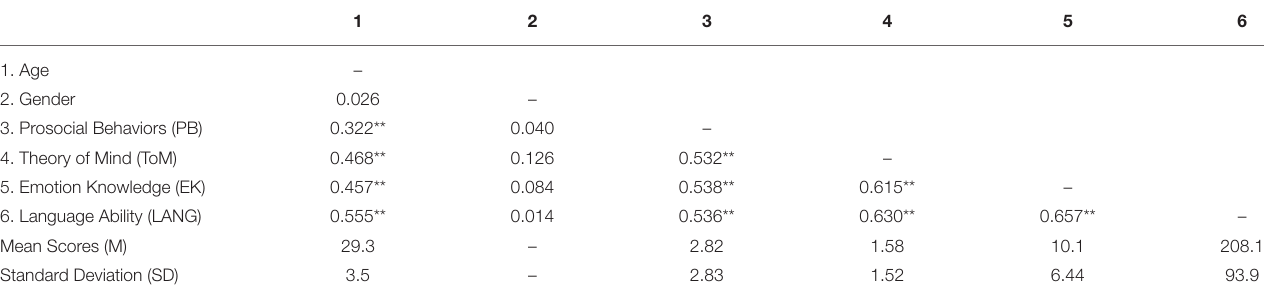
TABLE 1 | Main descriptive statistics and zero-order